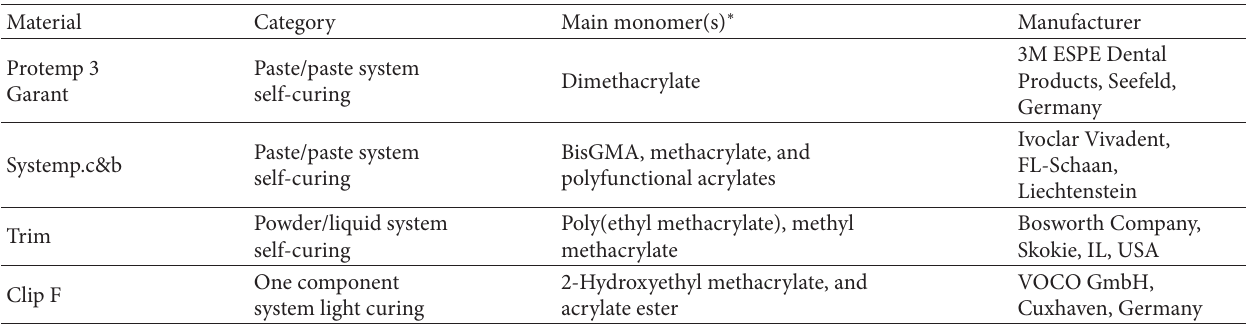
Table 1: Materials tested.